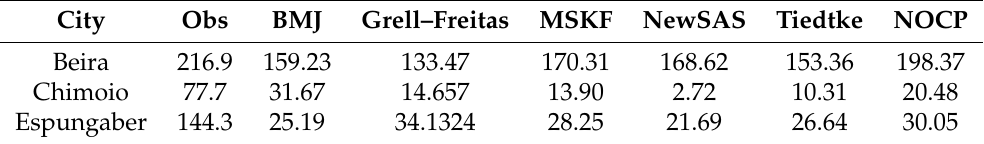
Figure 2. The ( a ) maximum wind speed (m/s) and ( b ) minimum sea level pressure (hPa) during the Idai tropical cyclone based on the Joint Typhoon Warning Center best track data (black line) as well as for GFS data (red line) for the 72 h period considered in this study. Table 2. The twenty-four-hour rainfall observed in three INAM stations as well as simulated rainfall from the nearest grid point to the station using the six simulations on 15 March